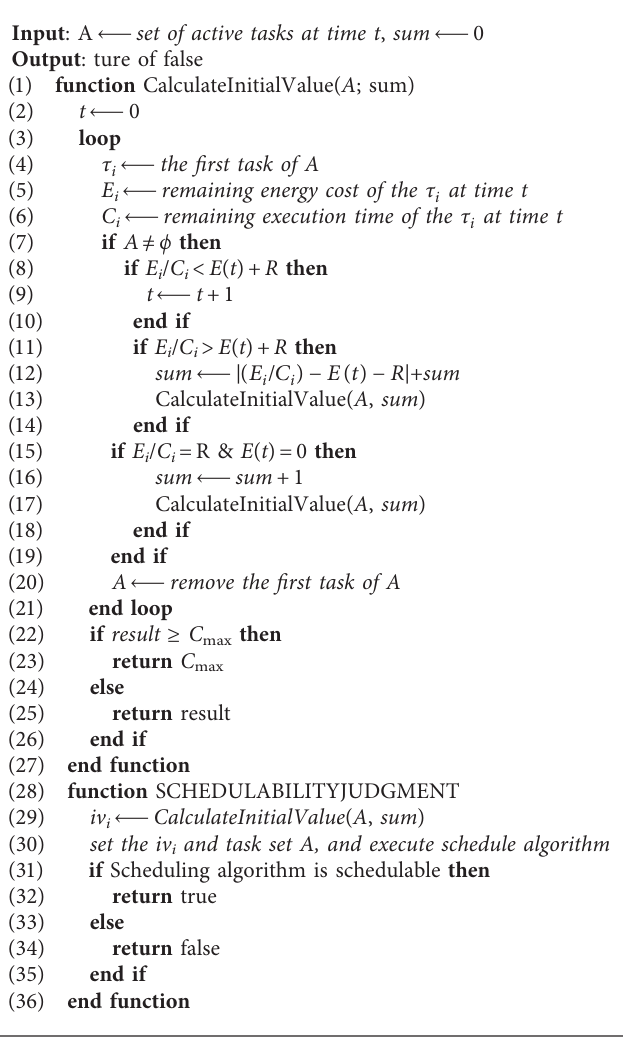
Table 1: Task set τ